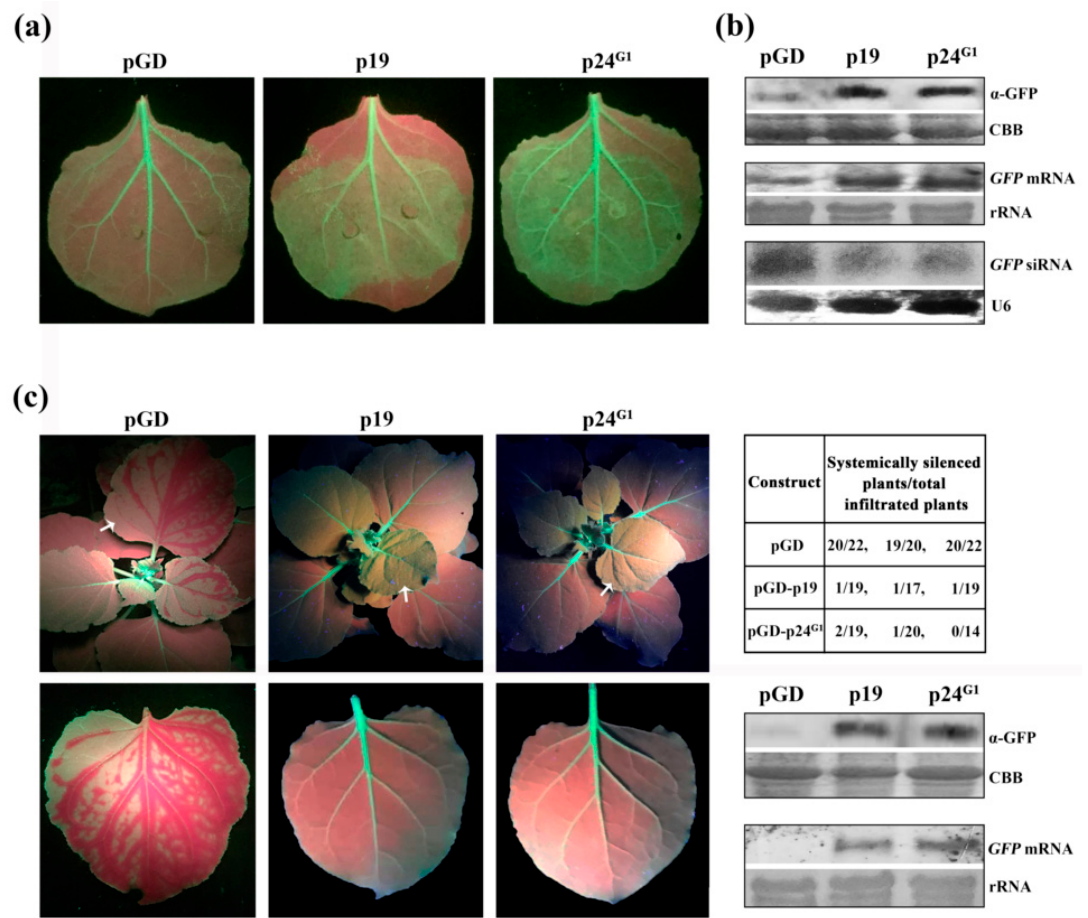
Figure 1. Suppression by p24 of grapevine leafroll-associated virus 1 (p24 G1 ) of local and systemic RNA silencing. ( a ) GFP image of agroinfiltrated patches of N. benthamiana line 16c under UV at 3 dpi. Each indicated GFP image is representative of more than 20 individual leaf samples from three separate experiments. ( b ) Quantitative assessment of GFP protein and mRNA, and GFP-specific siRNA accumulation. Total protein and RNA were extracted from the agroinfiltrated patches at 3 dpi. ( c ) Effect of p24 G1 on systemic silencing. Photographs were taken under UV light at 18 dpi, and leaves indicated by arrows are shown in the panels below. The number of plants that showed systemic silencing out of the total number of plants tested, 18 dpi, is indicated in the table. The lower right panel shows GFP protein and mRNA accumulation, 18 dpi, in the distal leaves of infiltrated plants. Coinfiltration of pGD – GFP and the empty vector pGD or pGD – p19 was used as negative or positive controls (a,c). CBB staining (b,c), Ethidium-bromide-stained rRNA (b,c) and detection of U6 small nuclear RNA (b) are shown as loading controls.